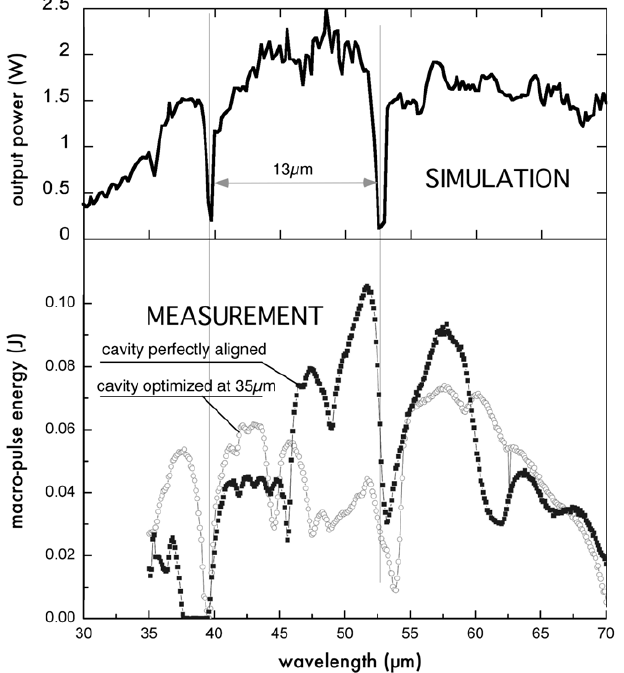
.FIG. 10. Results for the FELIX infrared FEL.